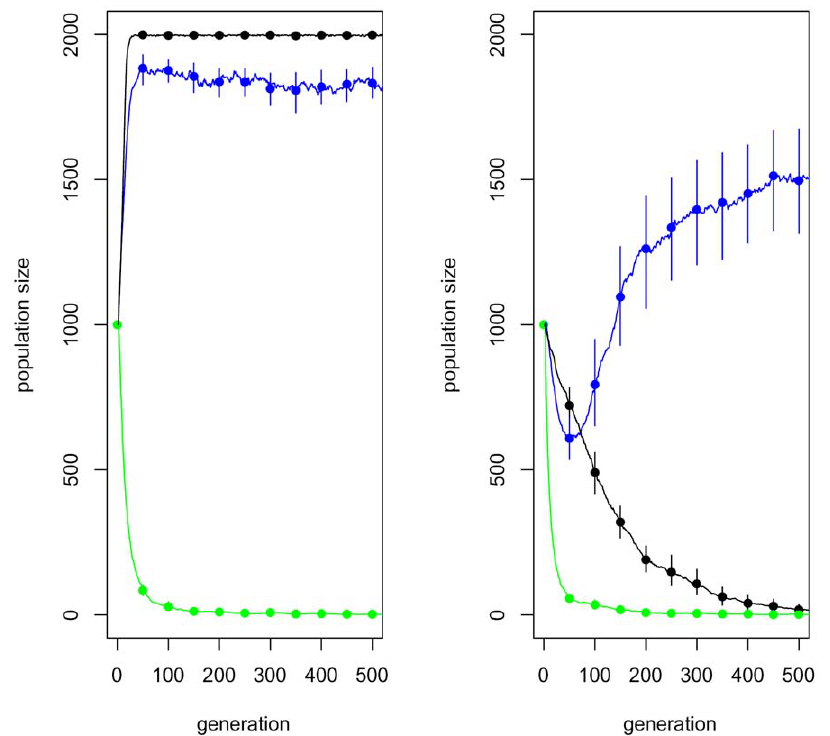
Figure 5. How sex reversal affects the population size. In panel A, the { allele is neutral. In panel B, the { allele is mildly deleterious ( s ~ 0 : 05 ), with other parameters as in ‘Baseline’, Table 1. Fecundity selection (Option b.) is assumed. The dots are estimates of the expected population size, whereas the error bars represent their uncertainty due to sampling error (95% confidence intervals). The black dots are calculated for a population with no sex reversal ( r ~ 0 ), the blue dots for a moderate rate of sex reversal ( r ~ 0 : 1 ), and the green dots for a pure environmental sex- determination system ( r ~ 0 : 5 ). A sample of 150 populations has been used in each case.